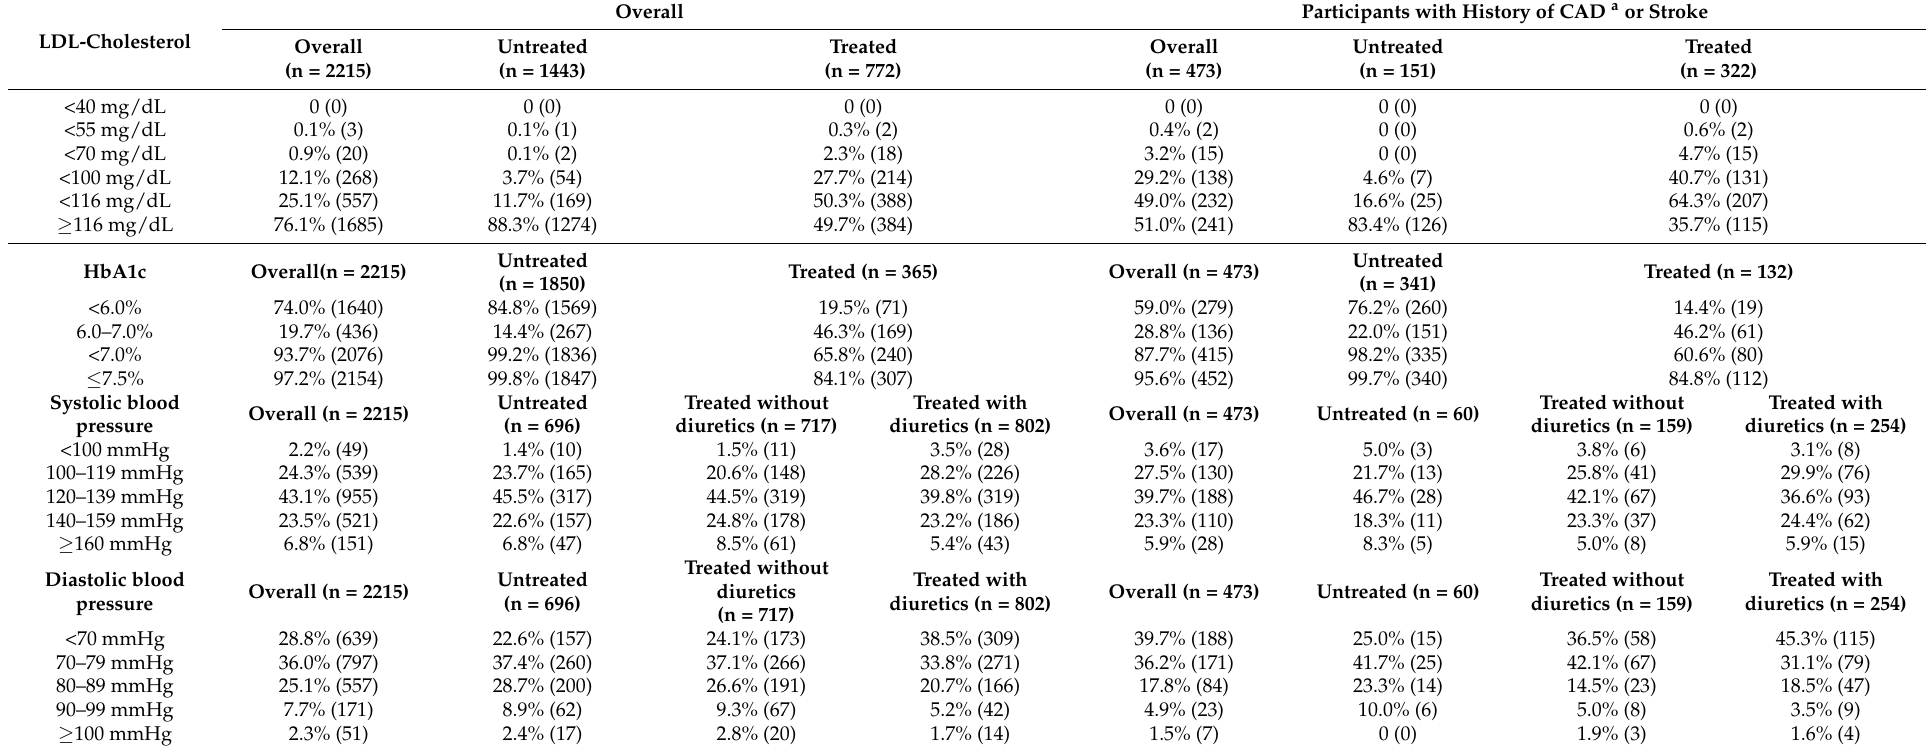
Table 3. Proportion of achieved and unachieved cardiovascular risk factor control. Shown is the proportion of the 2215 AugUR participants at recommended LDL-cholesterol, HbA1c, or blood pressure levels, overall and separately by individuals with or without the respective treatment. With regard to LDL-cholesterol, recommended levels of the European Society of Cardiology and Atherosclerosis (ESC/EAS) are presented [8]. For HbA1c, levels at <7.0% or ≤ 7.5% are recommended by the American and German Diabetes Association [6,7]; levels <6.0% can be a sign of hypoglycemia for diabetes patients [6]. For blood pressure, systolic and diastolic blood pressure ranges defined by the European Society of Cardiology and Hypertension are reported [9]. Shown are also the proportions of participants at recommended levels among the 473 individuals with a prior diagnosis of CAD or stroke. These individuals are at high risk for cardiovascular events, where stricter medication and stricter goals are